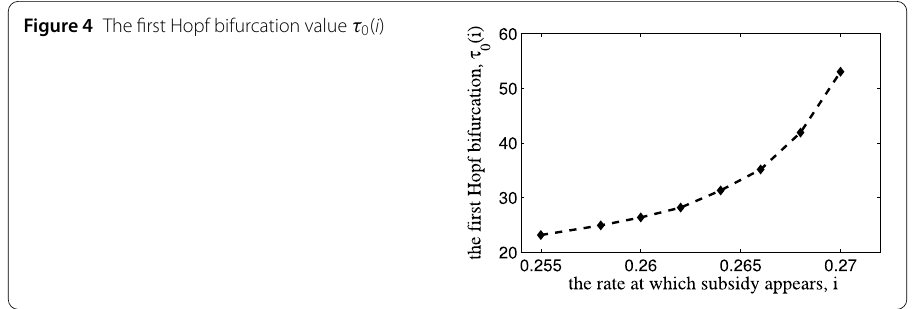
Figure 4 The first Hopf bifurcation value τ 0 ( i